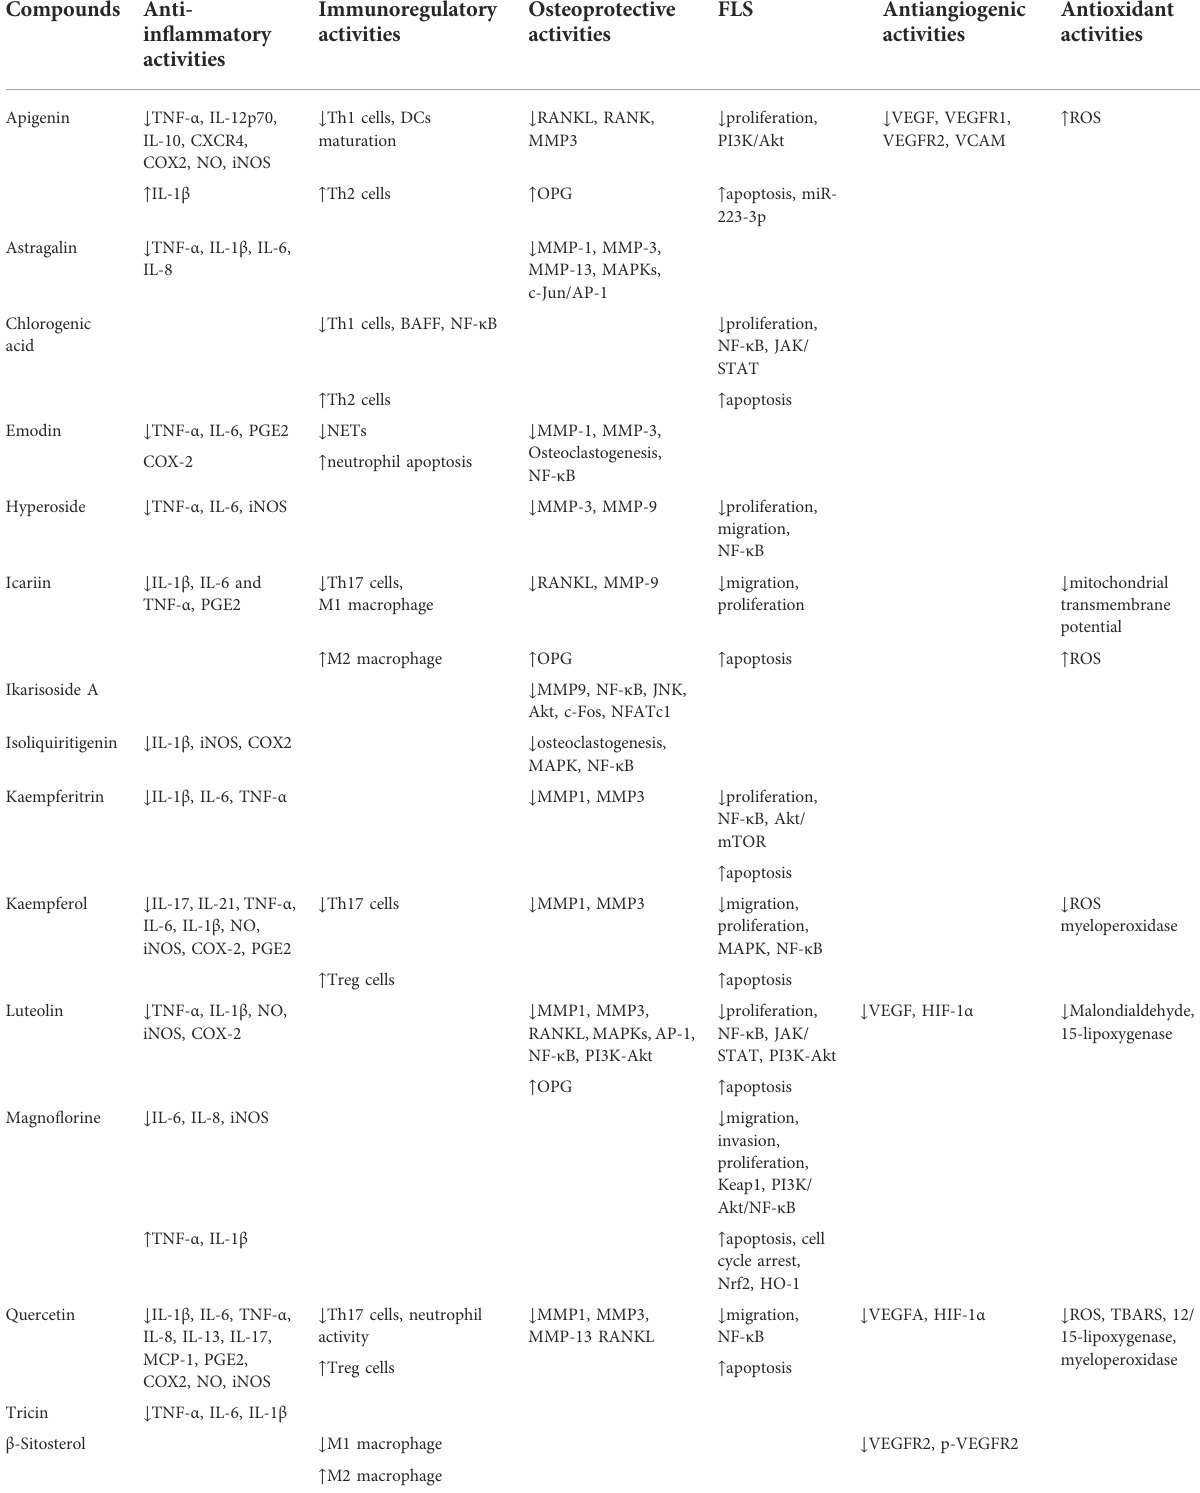
TABLE 5 The mechanism of compounds from EH for the treatment of